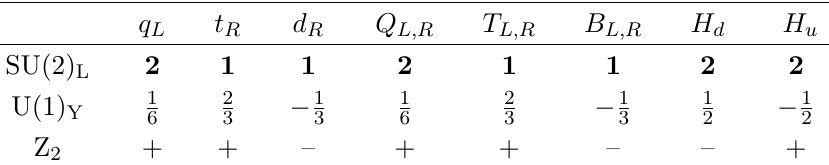
Table 1 . Quantum numbers of the 3rd generation standard model quarks ( q L ; t R ; d R ), extra vectorlike quarks and the two Higgs doublets. The electric charge is given by Q = T 3 + Y , where T 3 is the weak isospin, which is +1/2 for the (cid:12)rst component of a doublet and -1/2 for the second